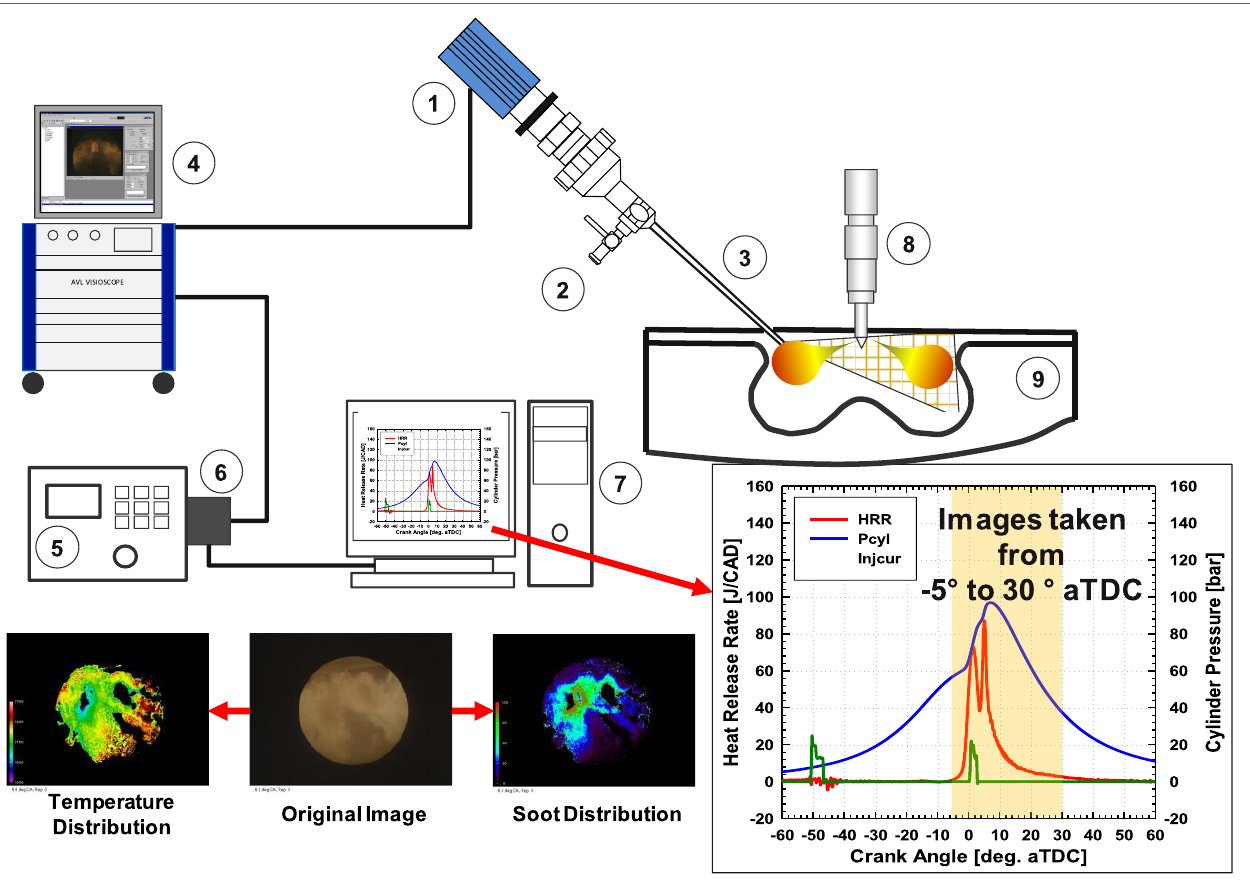
FigUre 2 | Endoscope setup: (1) charge coupled device camera; (2) air cooling port; (3) cylinder head and endoscope window; (4) AVL Visioscope system; (5) alternating current dynamometer; (6) encoder; (7) data acquisition system; (8) injector; (9) piston. Lower right, timing period [crank angle degree (CAD)] that endoscope images cover ( − 5° to 30° aTDC); lower left, original image (flame luminosity) and postprocessed images of soot and temperature distributions. aTDC, after top dead